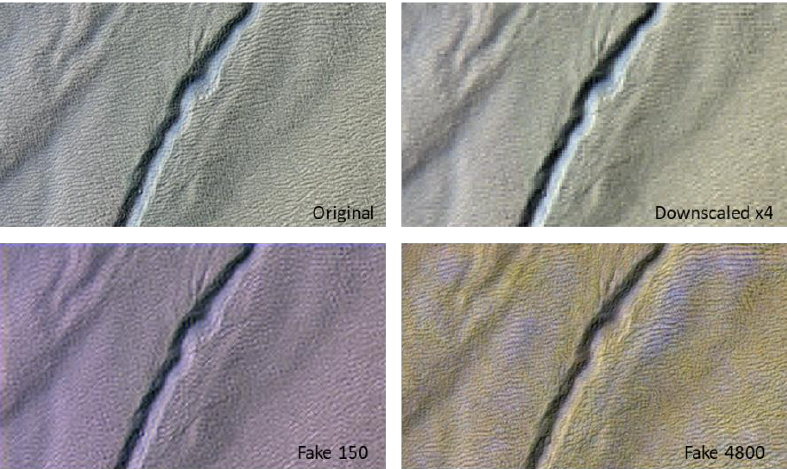
Figure 6. Example of results that were obtained for 150 and 4800 epochs of the “Mars” theme. Figure 7 is equivalent to Figure 6, but was obtained for a forest theme.